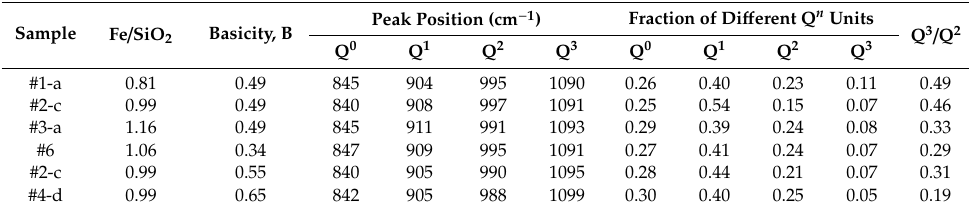
Table 6. FTIR peak shift and area fraction obtained from FTIR spectra of FCSM-Cu 2 O-PdO slags of di ff erent basicity and Fe / SiO 2 ratios.